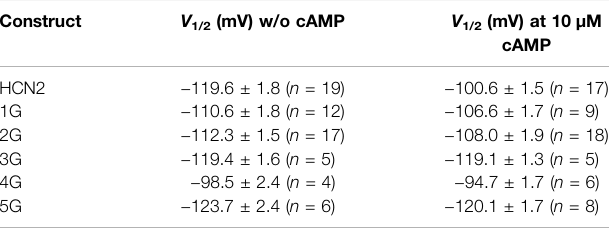
TABLE 2 | Half-maximum activation in the absence of cAMP and at 10 µM cAMP (mean ± SEM). Number of recordings, n, are given in brackets for each construct and